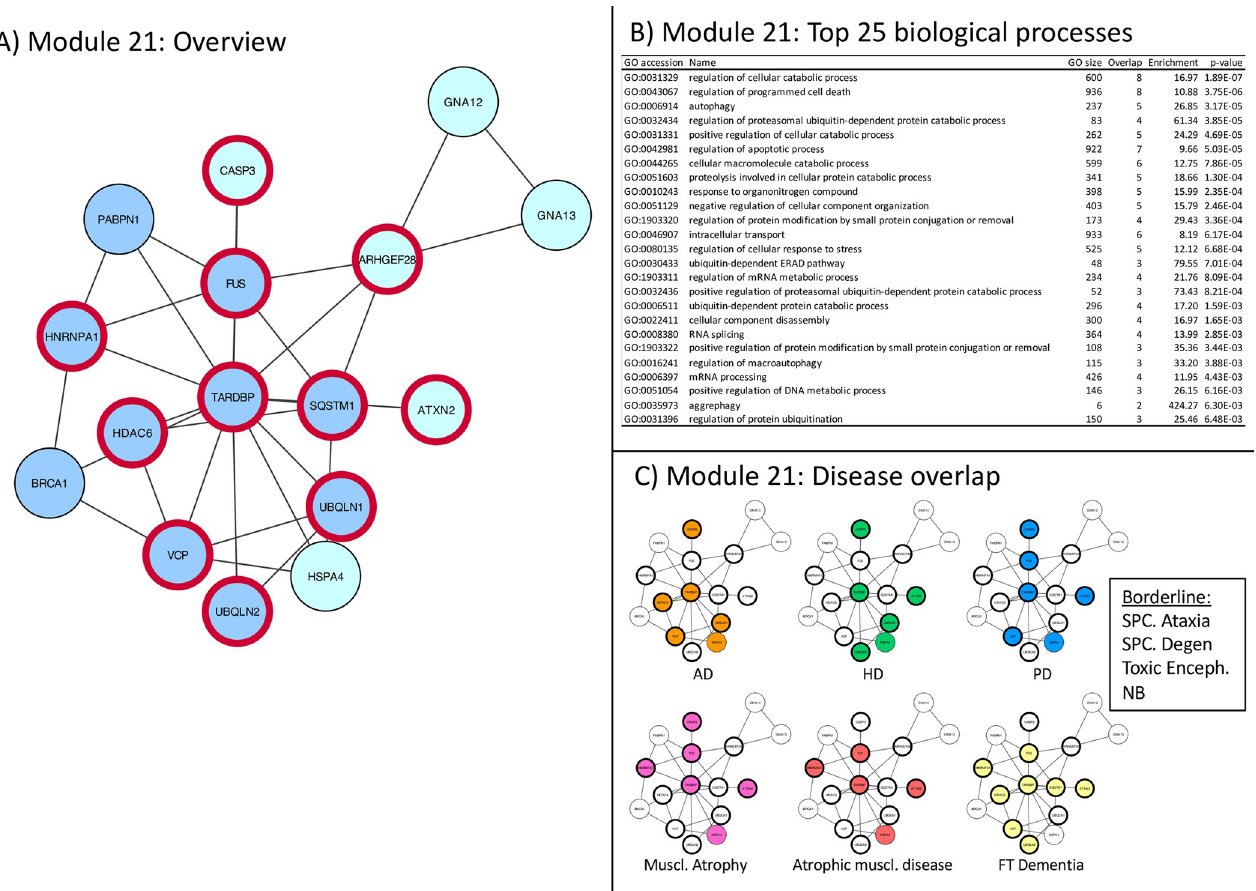
Fig 9. Module 21 –weakly classified biology, strong disease overlap. Panel A: thick red border: gene/protein annotated to be ALS-associated on any of the 7 lists. Large red label: gene/protein with GWAS evidence. Triangular shaped nodes: receptors (UniProt keyword). Node colors indicate subcellular location (UniProt keywords): Blue = Nuclear, Green = Secreted, Purple = conflicting nuclear/secreted, cyan = neither nuclear nor secreted (likely cytosolic). Panel B: Gene Ontology overrepresentation analysis. Panel C: Thick border: ALS-associated (as panel A), Colored node: Disease-associated gene/protein.